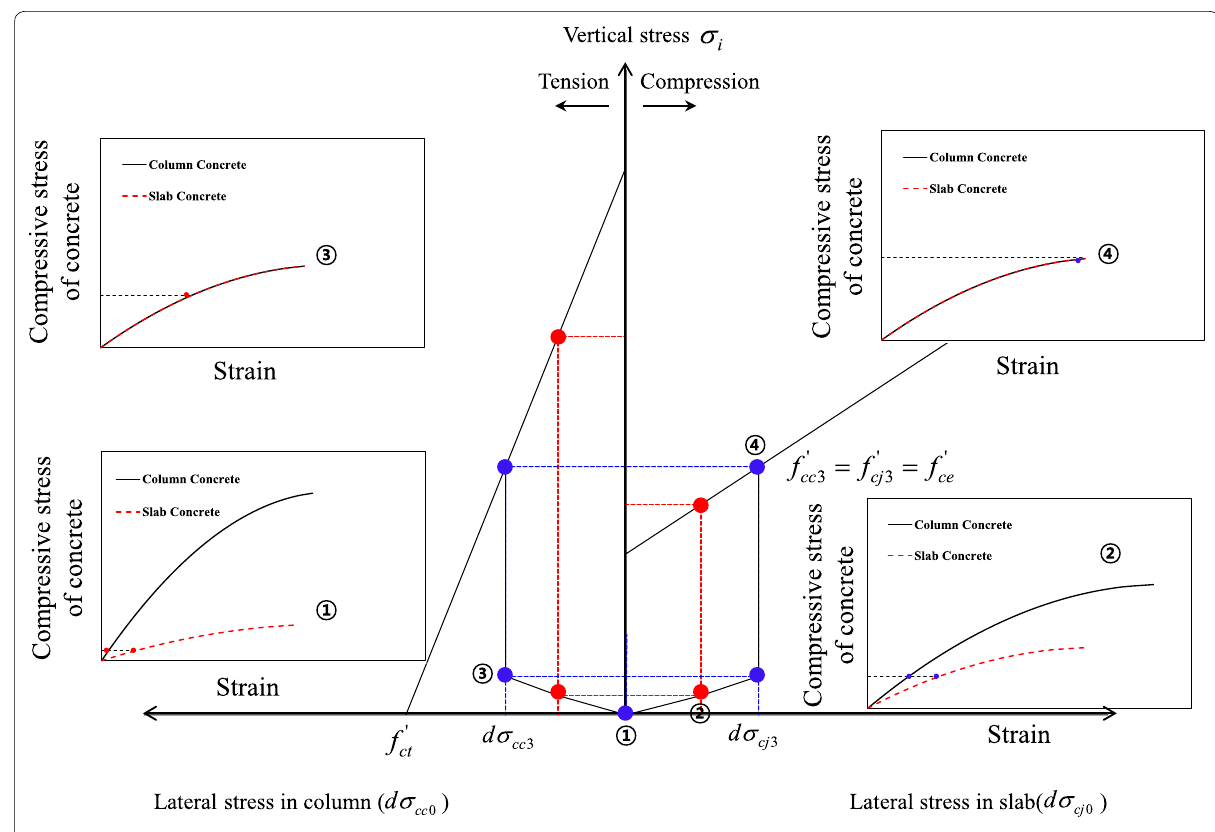
Fig. 3 Process of proposed